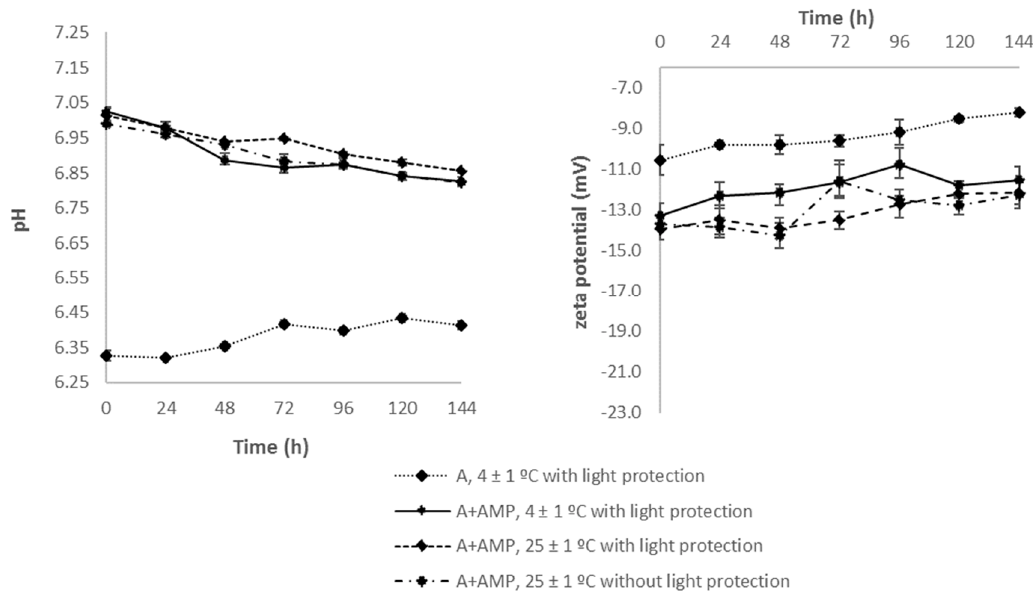
Figure 3. Values of pH and zeta potential of studied basic composition of TPN admixtures with (A + AMP) and without AMP (A) during storage at different conditions. Results are shown as the mean values of three samples ± SD. Table 2. MDD of lipid emulsion in studied TPN admixtures during storage. Results are shown as the mean values of three samples ± SD.